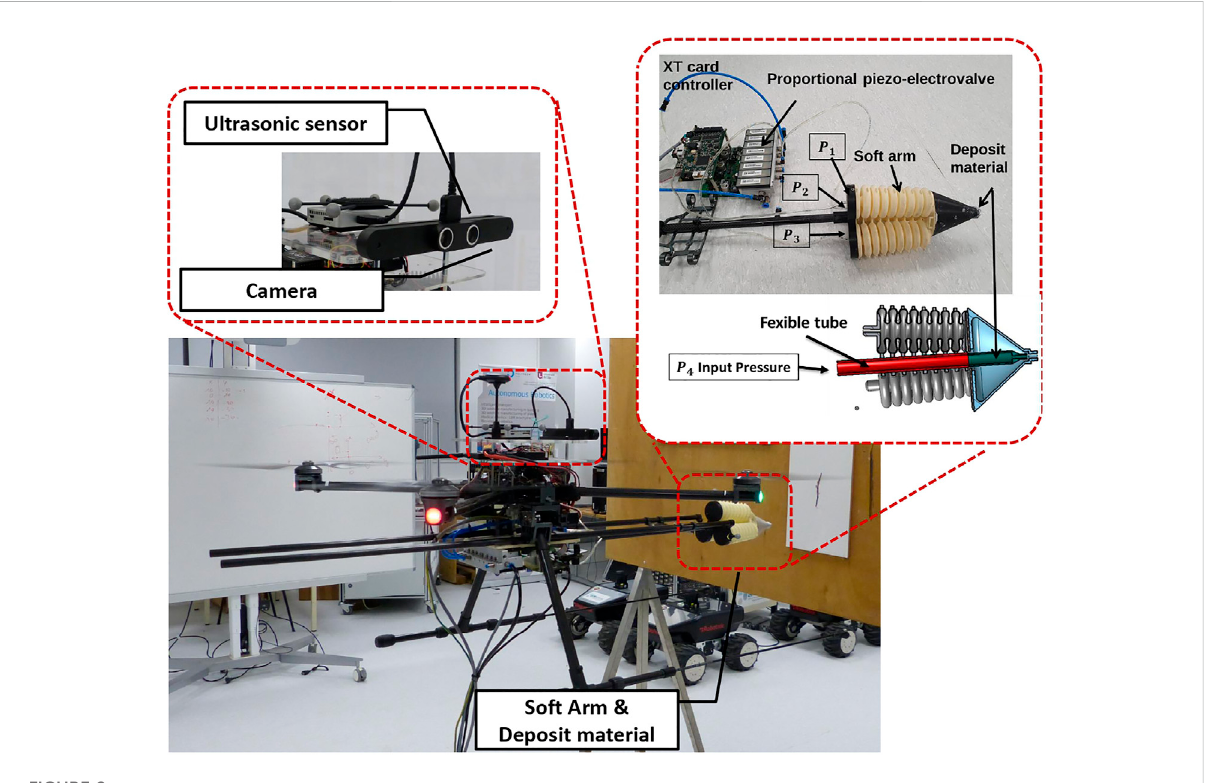
FIGURE 2 Predictive maintenance robot system.